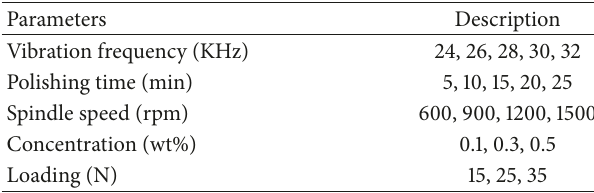
Table 2: The variable parameters of UV polishing